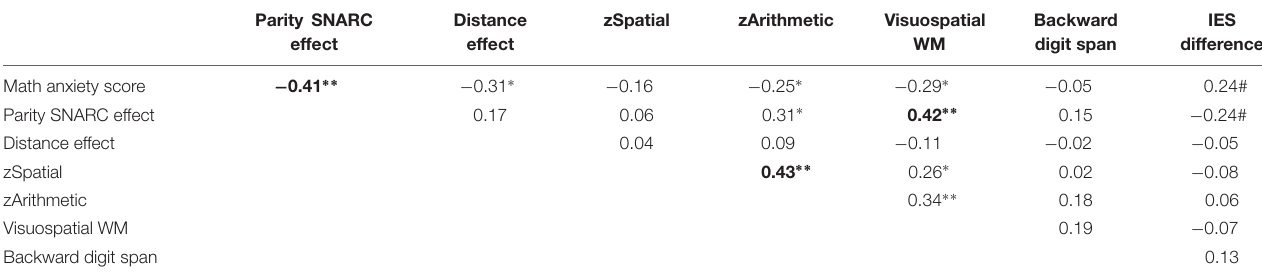
TABLE 3 | Correlation analysis for N = 61.